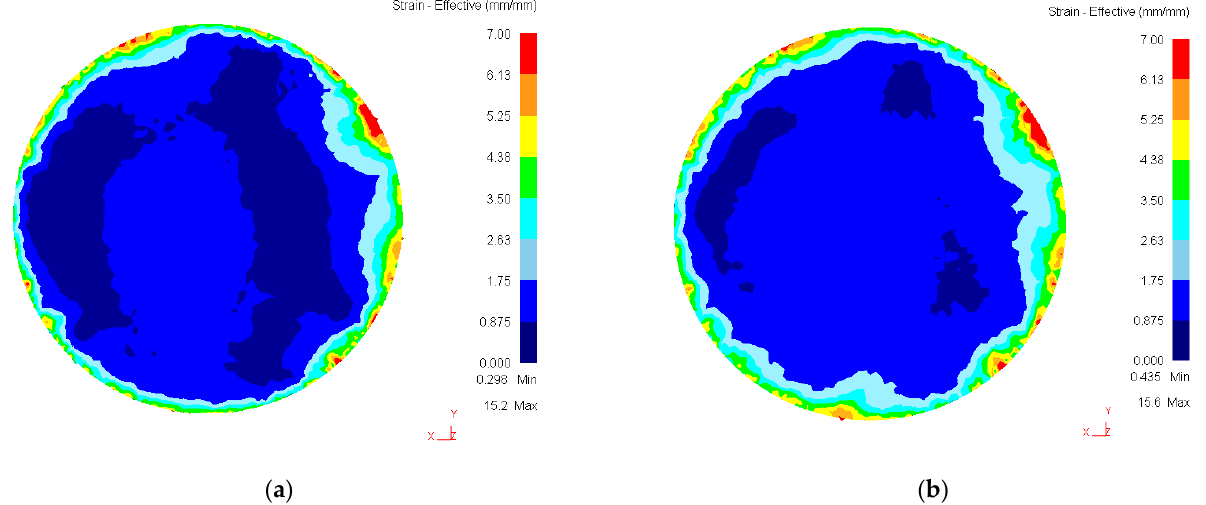
Figure 7. Distribution of accumulated strain intensity after 1 and 5 revolutions of HPT: ( a ) 1 revolution; ( b ) 5 revolutions.